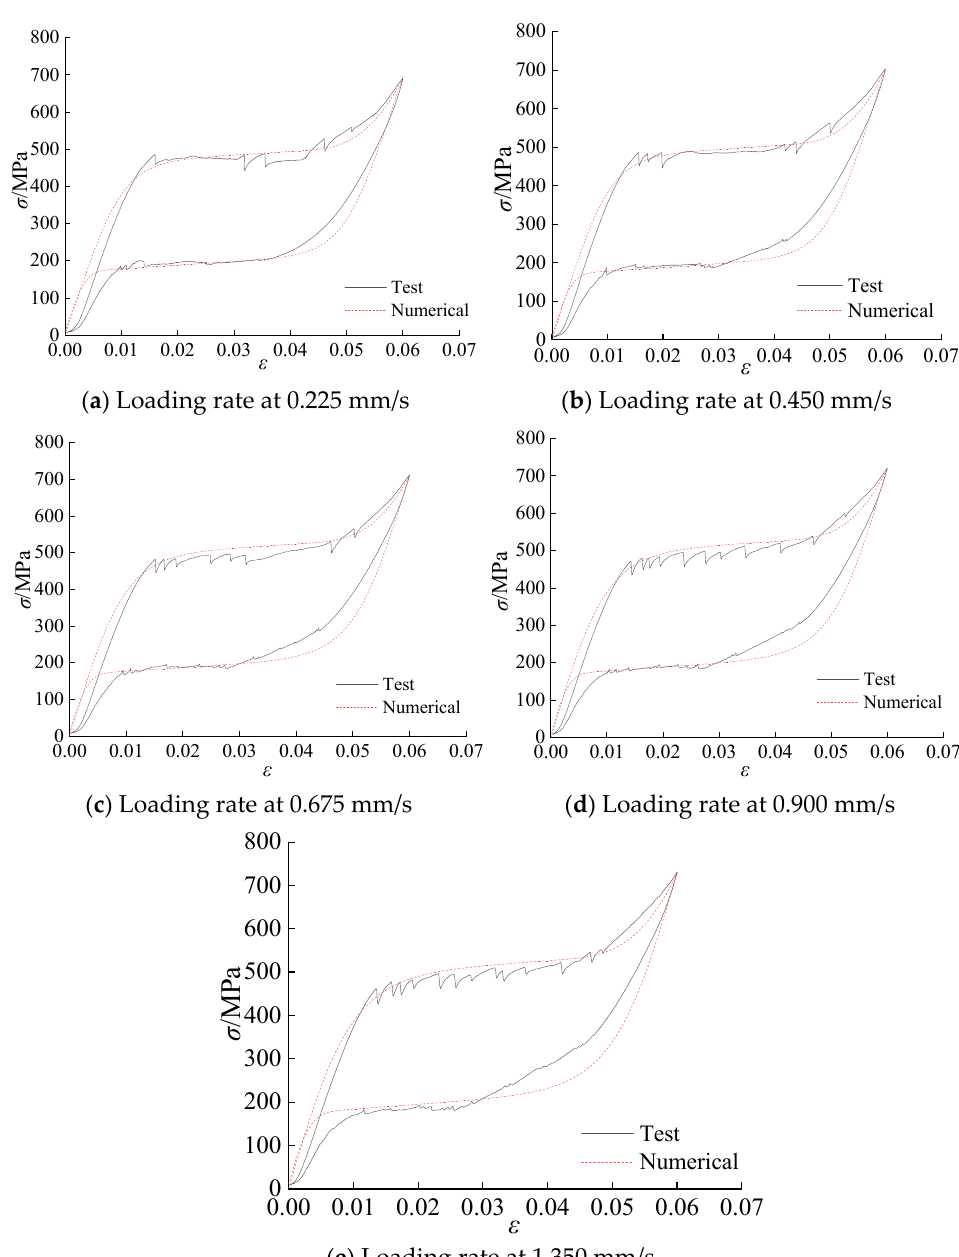
Figure 8. Comparison of the test and numerical curves under different loading rates.